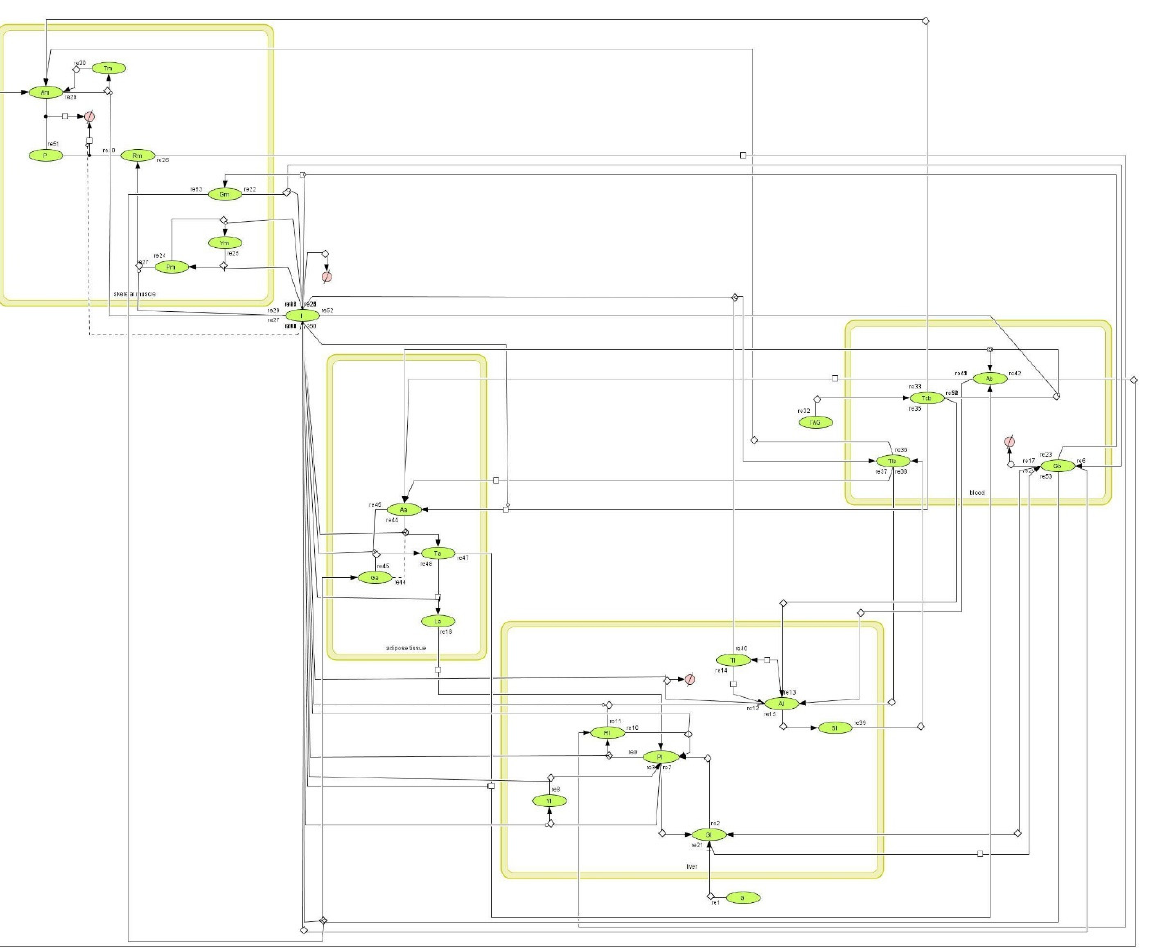
Figure 3. CellDesigner model of hepatic lipid metabolism model.